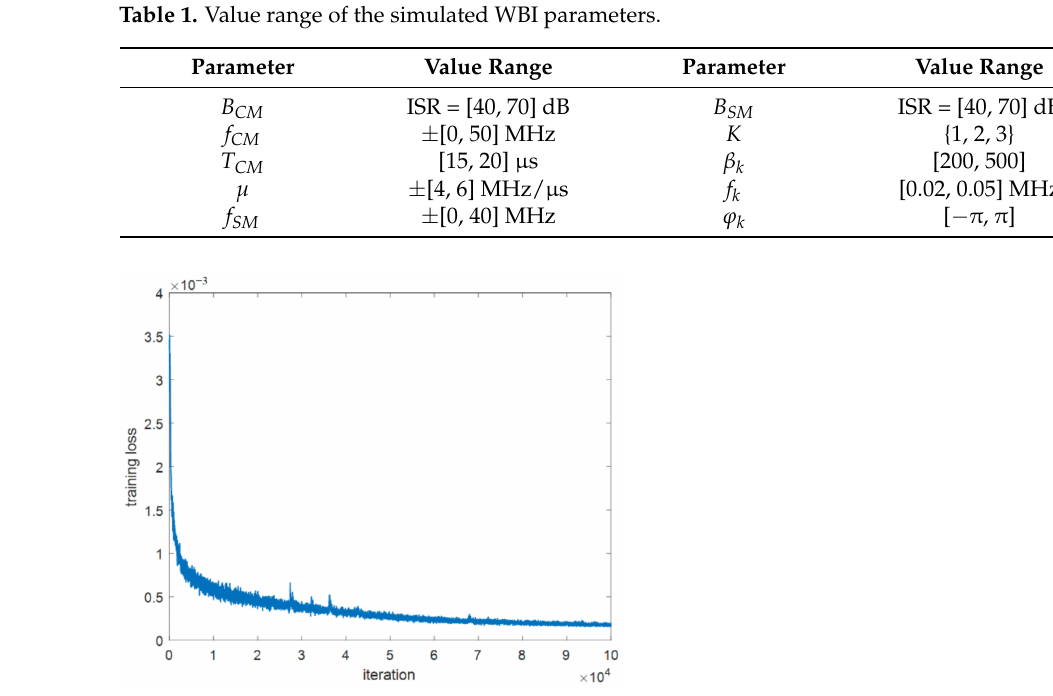
Figure 4. The training loss of PredRNN versus the training iterations. With the input as X I = (cid:104) X 1 , X 2 , . . . , X 10 (cid:105) , Figures 5–7 show the prediction results (cid:11) ˆ X ˆ X ˆ X = (cid:10) ˆ X obtained by the trained PredRNN for three different testing 20 O 12 , 14 , . . . ,